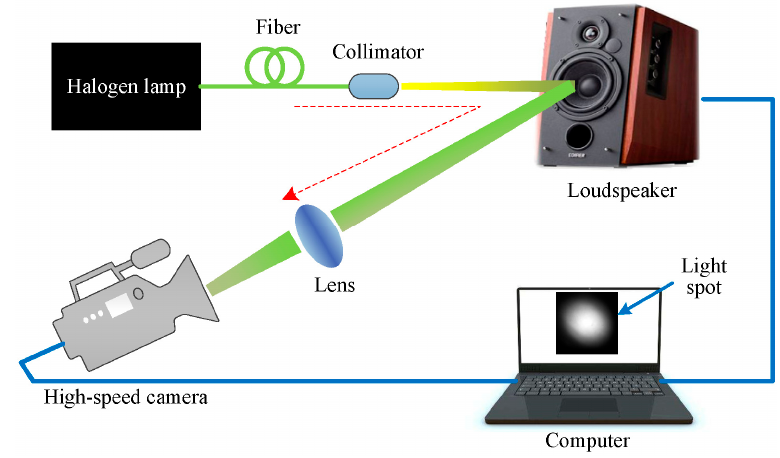
Figure 2. The simulation setup. The red dashed arrow line indicates the light path.